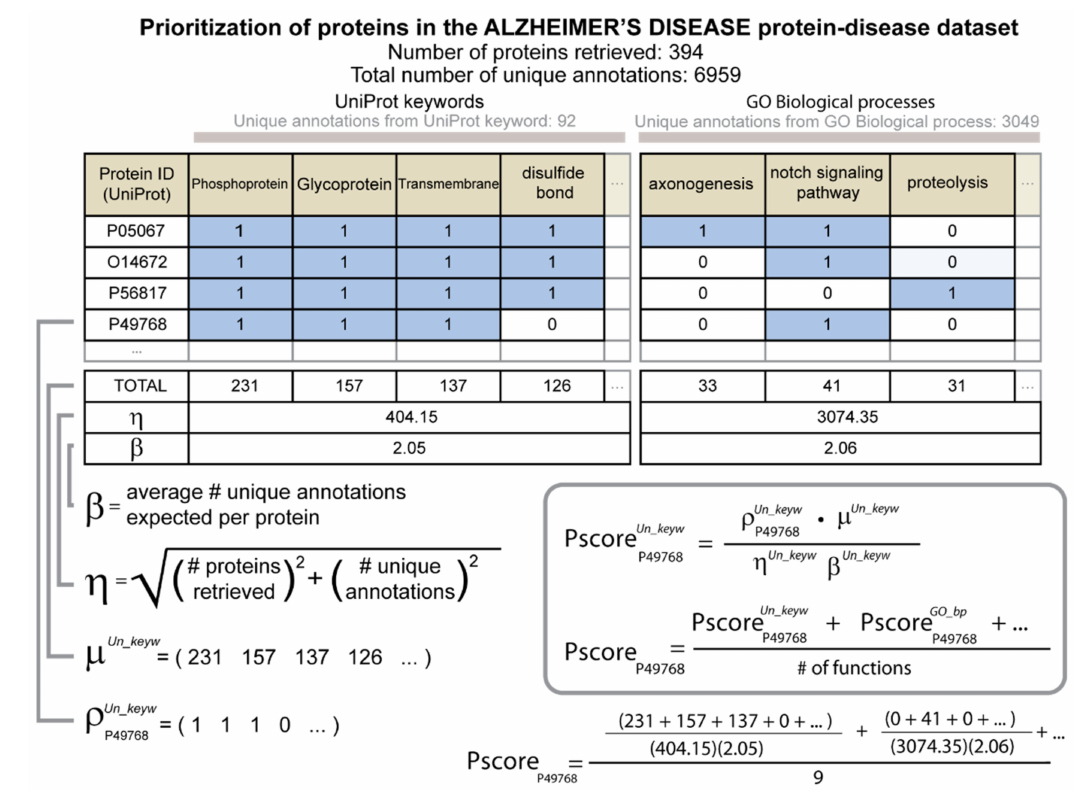
Figure 1. Diagram describing how priority scores are calculated. The protein–disease dataset for AD is used in the example. The proteins are identified by their corresponding accession codes in UniProt. A unit matrix is then created where the rows are the UniProt entries, and the columns are specific functions. The 1D array rho, ρ , is a binary array that represents the presence or absence of each function for a given UniProt entry. The 1D array mu, µ , holds the total number of UniProt entries for each function among the proteins of the protein–disease dataset. The dot product of rho and mu produces a raw priority score. The factor eta, η , is one of the variables that is used to normalize the raw priority score. Eta is calculated by summing in quadrature the total number of UniProt entries and the total number of functions associated with the disease for a given type of function. A second normalization factor beta, β , is the average number of unique functions per protein of a given type of function. The priority score of a protein is the mean of the normalized priority scores that were calculated separately using each of the different types of